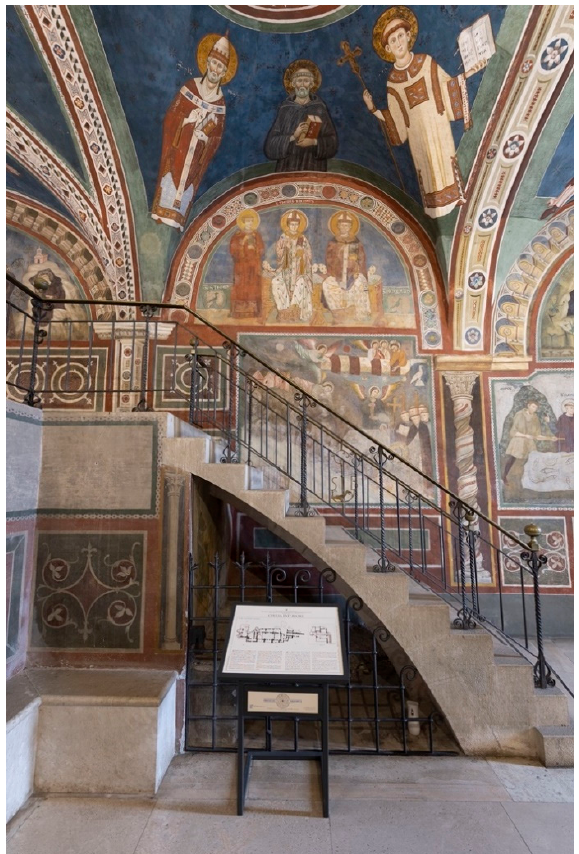
Figure 15. Sacro Speco, Subiaco (Italy), Lower Church. Frescoes. Lunette with St. Stephan, St. Thomas Becket, St. Nicholas and Funeral of St. Benedict. Photo: Davide Giannetti.